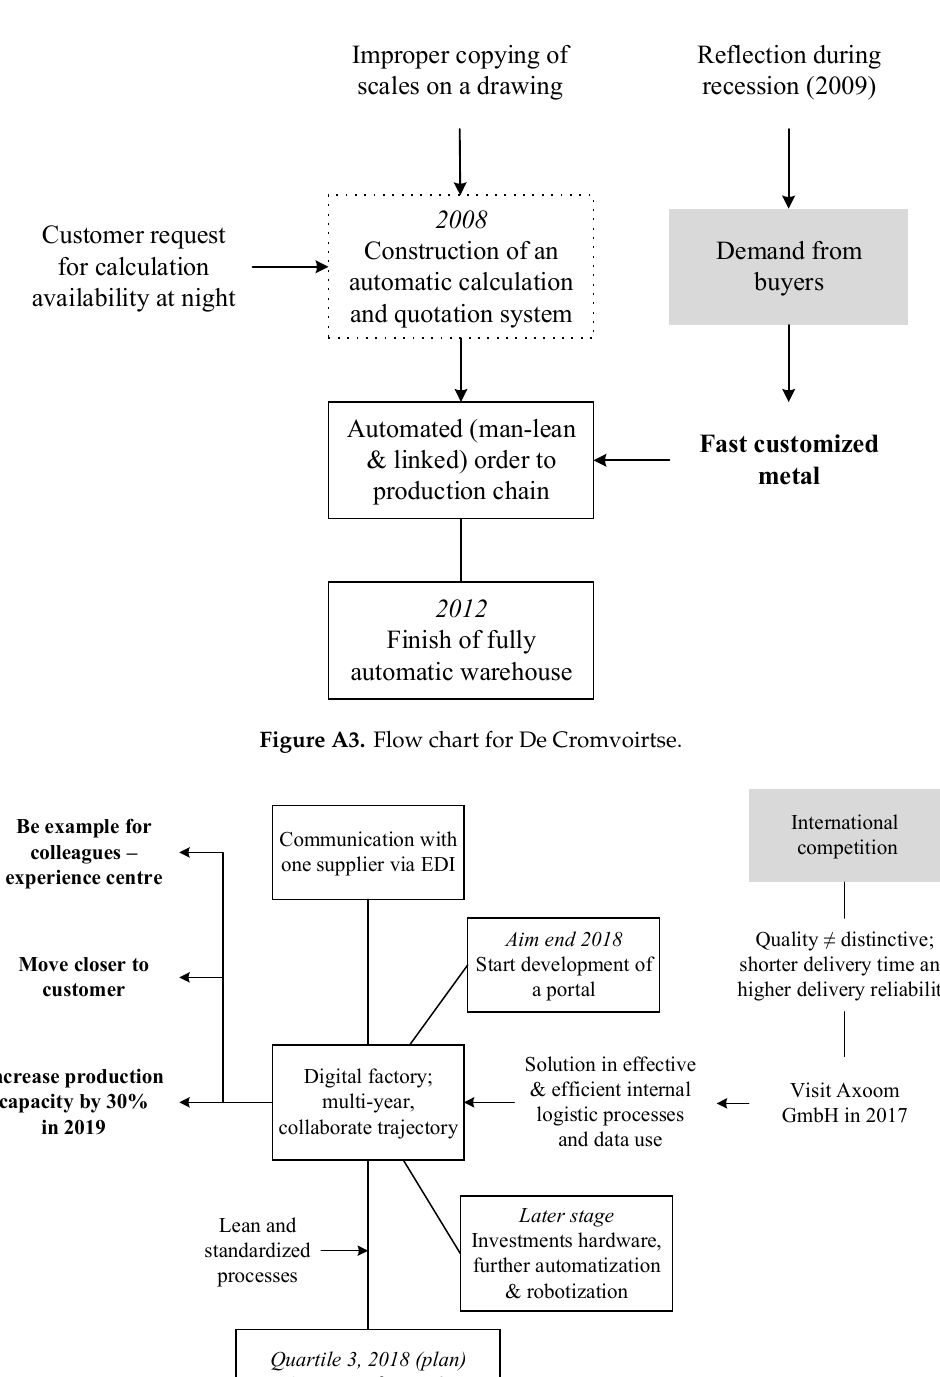
Figure A2. Flow chart for Bruil.